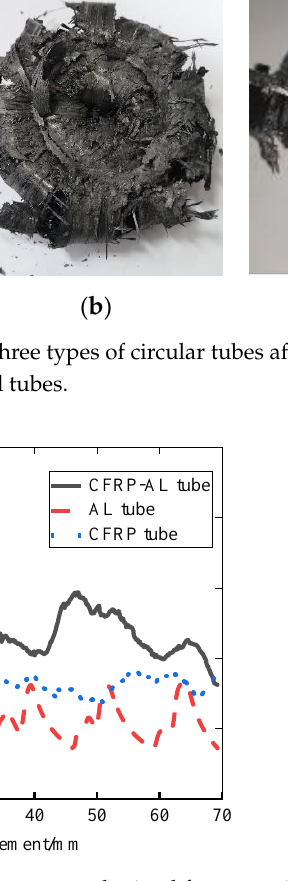
Figure 5. Load – displacement curves obtained from quasi-static crushing tests.